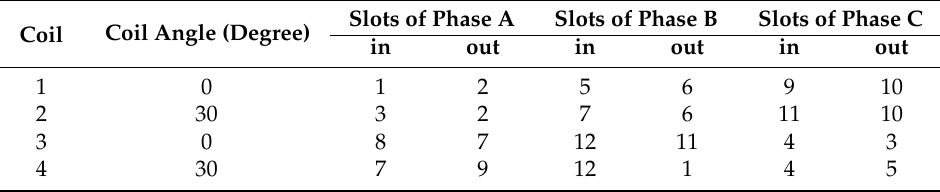
Table 2. Winding layout and coil angles of the AFPM